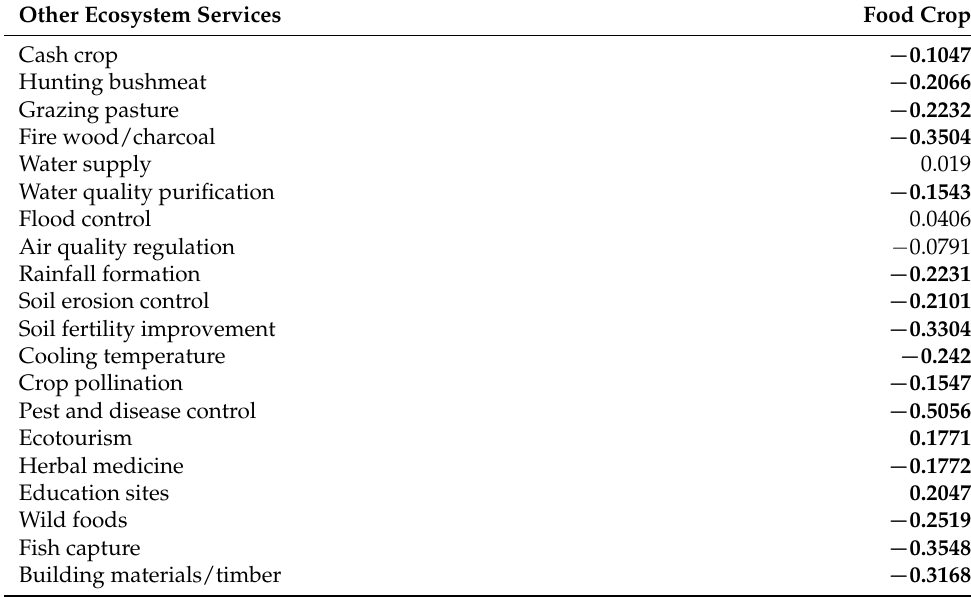
Table 4. Correlation between different ecosystem services. In bold are those correlations that have p values < 0.0001. The whole pairwise correlation matrix is in Table